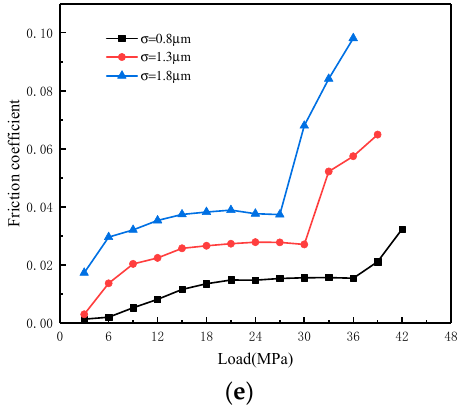
Figure 16. Influence of surface roughness on lubrication performance. ( a ) Calculated film thickness; ( b ) Calculated asperity contacts; ( c ) Calculated friction components; ( d ) Calculated friction coefficient; ( e ) Calculated ultimate load.